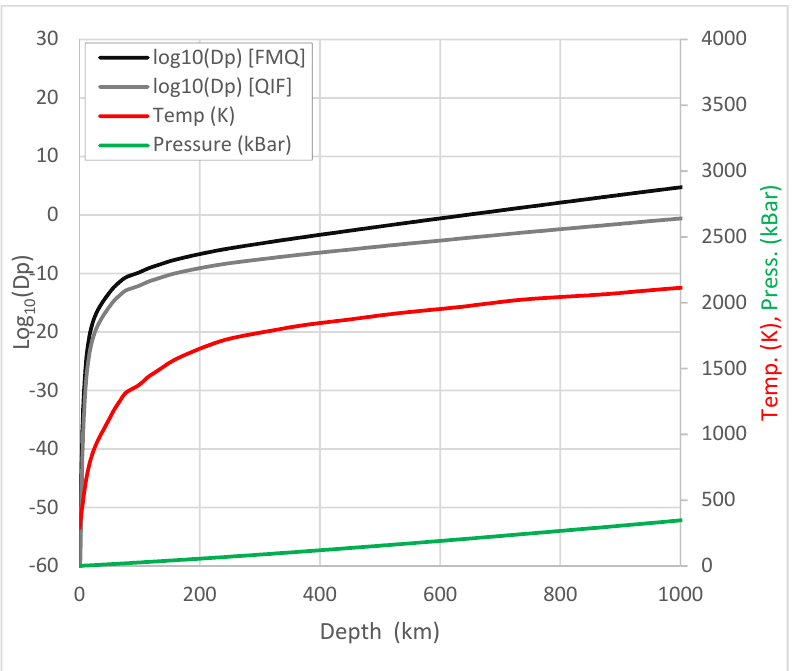
Figure 2. Phosphorus partitions into silicate above 1000 km depth. The partition coefficient of phos- phorus D p between metallic and silicate phases predicted for the mantle shows that below 600 km (for a mantle at FMQ reduction) or 1000 km (for a QIF mantle) is the majority of phosphorus in the metallic phase as iron phosphide. X -axis—depth below the surface (km). Left-hand Y -axis: Partition coefficient D p of phosphorus between metallic and silicate phase expected at that depth. Right Y - axis: pressure (green) and temperature (red) at that depth.